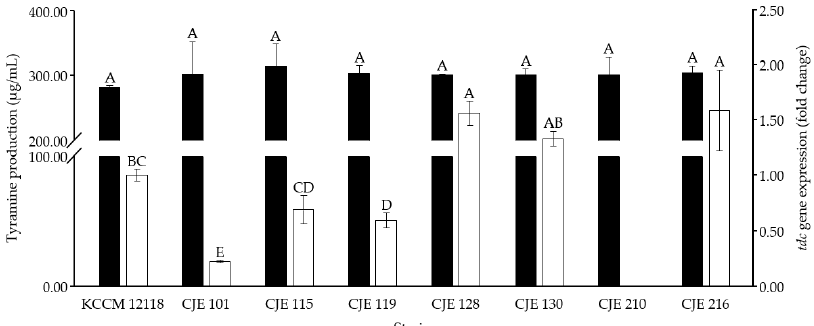
Figure 2. Comparison of tyramine production and tdc expression by E. faecium strains. ■ : tyramine production, □ : tdc gene expression. The expression levels observed in E. faecium strains isolated from retail Cheonggukjang products were normalized to that detected in E. faecium KCCM 12118 (type strain). The tdc gene expression was not detected in E. faecium strain CJE 210. Mean values followed by different letters are significantly different ( p < 0.05). Error bars indicate standard deviations calculated from duplicate experiments.